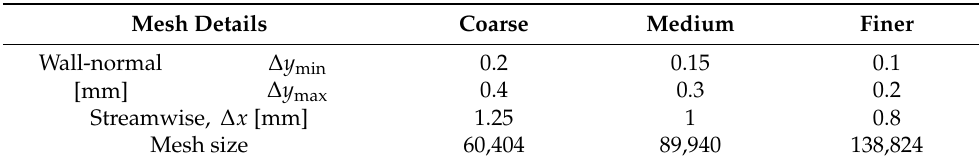
Figure 2. Overset grid of the flow domain . Table 2. Summary of the mesh densities . Table 2. Summary of the mesh